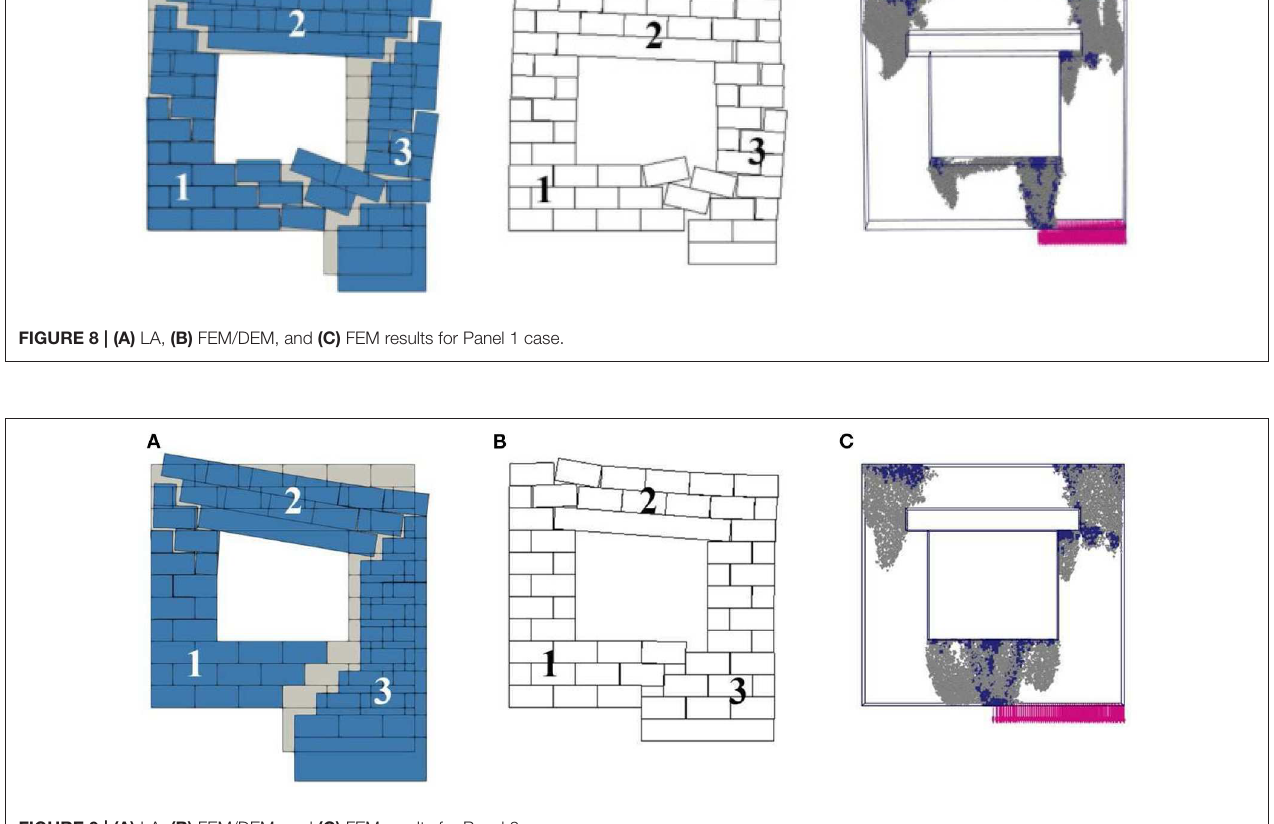
Frontiers in Built Environment |